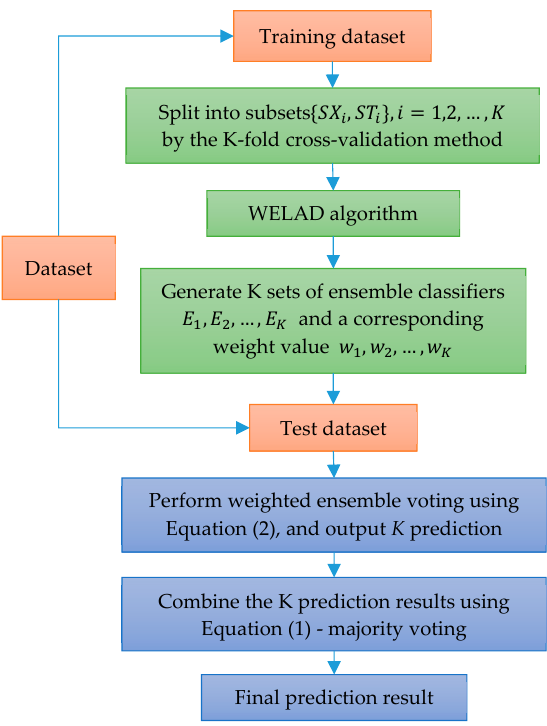
Figure 2. Architecture diagram of the weighted ensemble.